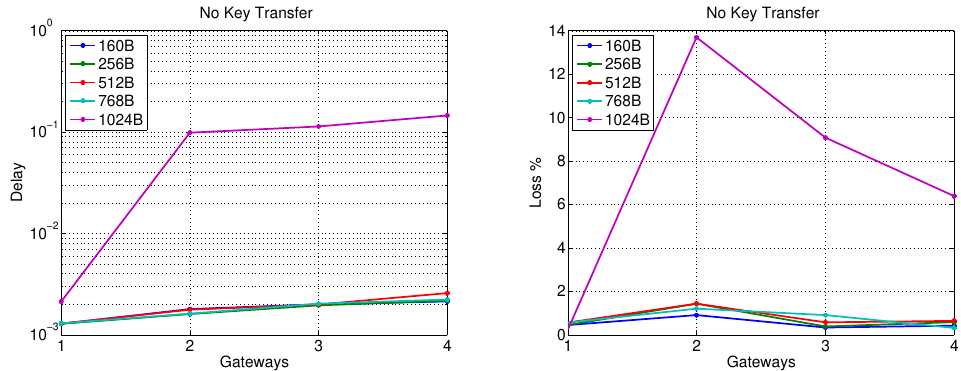
Figure 11. Gateway-PS communication performance for different number of gateways (no key transfer).